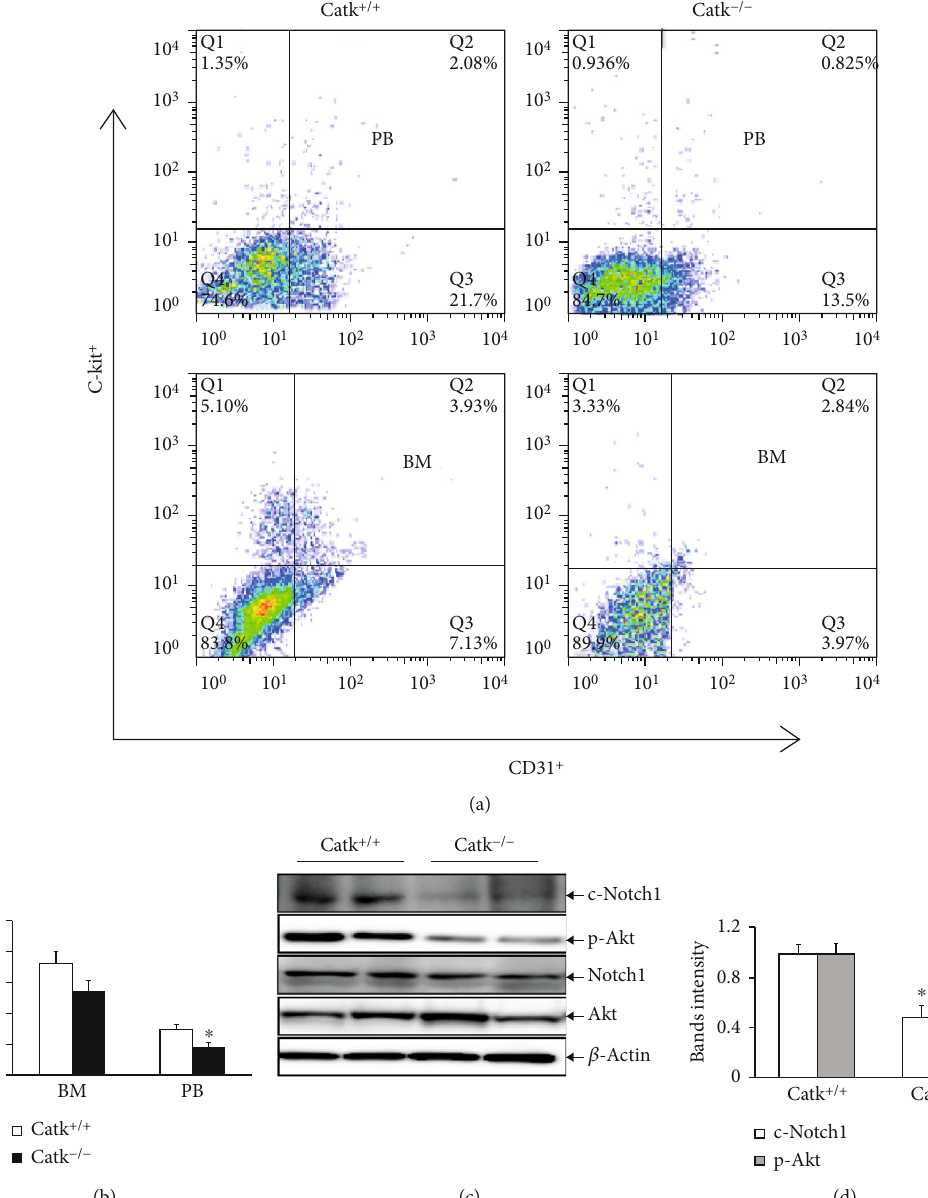
Figure 3: CatK − / − impairs bone marrow-derived CD31 + c-Kit + EPC-like cell mobilization. (a, b) Representative fl ow cytometry plots and quantitative analysis data show the numbers of CD31 + c-Kit + cells in bone marrow (BM) and peripheral PB of both genotypes of old mice (counted total 2 × 10 4 MNCs) at day 7 after ischemic surgery. (c, d) Representative immunoblot images and combined quantitative data show that CatK − / − reduced the levels of c-Notch1 and p-Akt proteins in bone marrow-derived c-Kit + cells. Data are mean ± SEM ( n = 3 – 6 ). ∗ p < 0 : 05 by ANOVA and Tukey ’ s post hoc